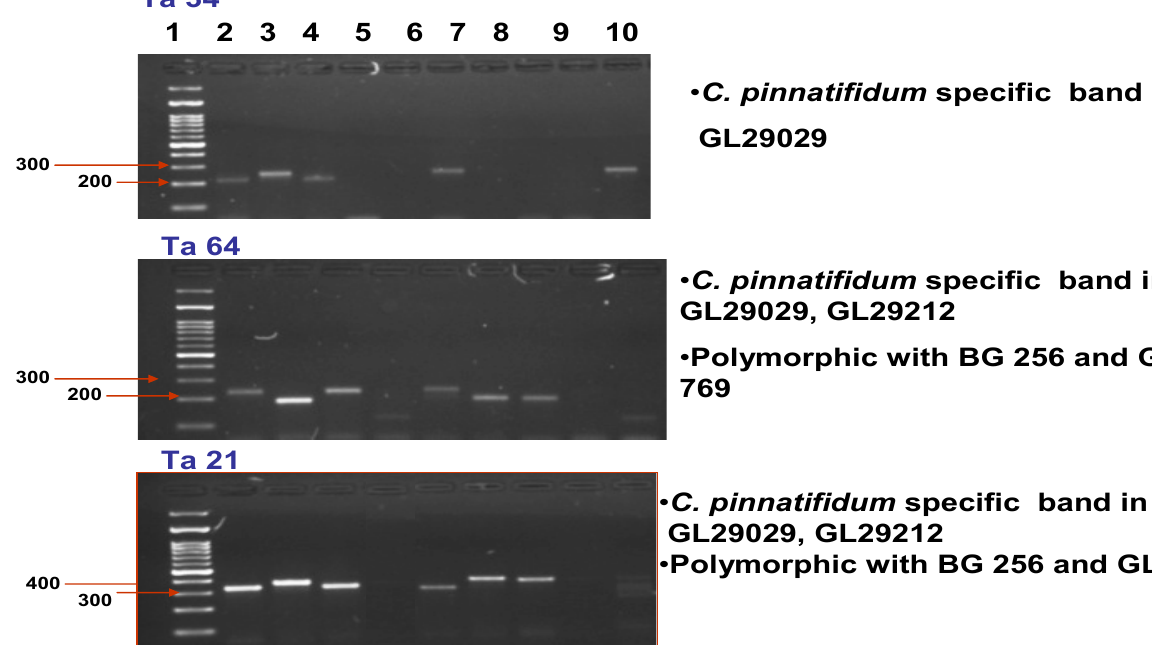
Figure 1. PCR amplified products with SSR primer Ta34 and Ta 64. Lane 1, Ladder 100 bp; 2, C. pinnatifidum 188; 3, ICCV 96030; 4, GL 29029; 5, GL29026; 6, GL29081; 7, GL 29081; 8, BG 256; 9, GL 769; 10, C. pinnatifidum 212. A) C. pinnatifidum spe- cific band in GL29029; B) C. pinnatifidum specific band in GL29029 and GL29212; polymorphism between BG 256 and GL769.